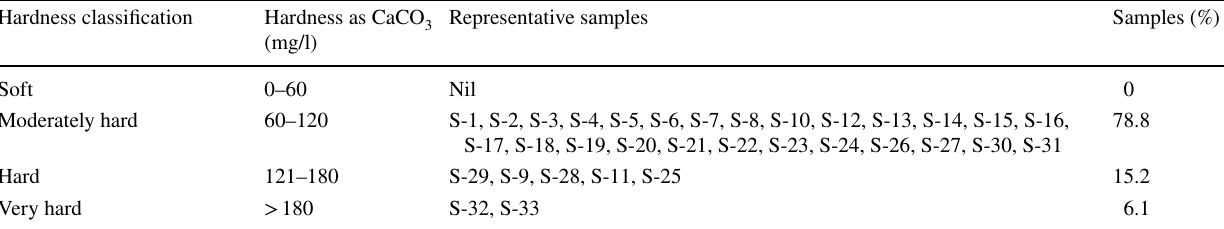
Table 2 USGS hardness classification of groundwater samples for the study area Hardness classification